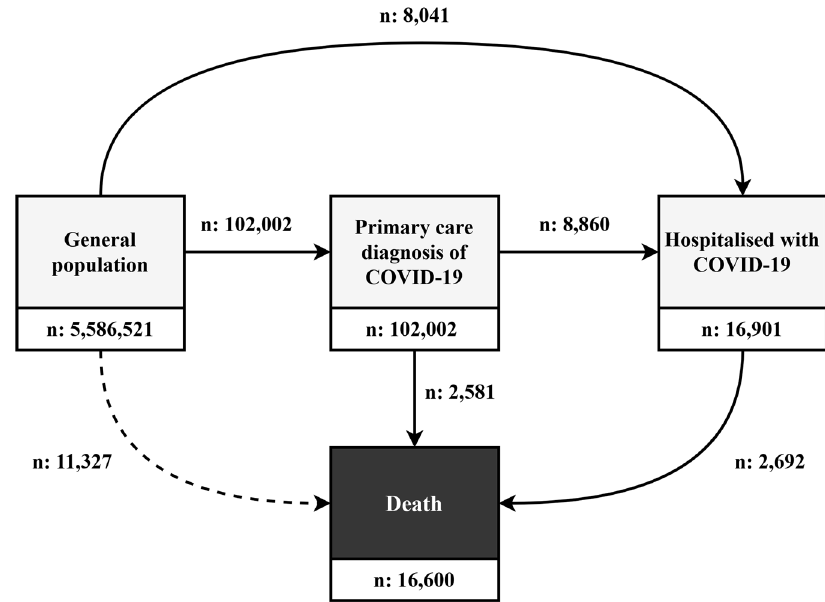
Fig. 1 Multi-state model of COVID-19. The entire study population began in the general population state as of the 1st March 2020, with progression through the model possible up to 6th May